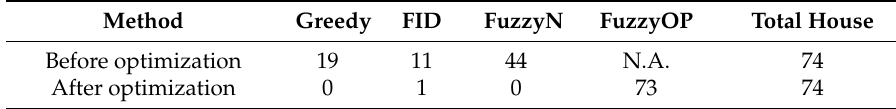
Table 4. Outperformance times of different power dispatch method in 74 houses. Table 5. The average costs of different methods.